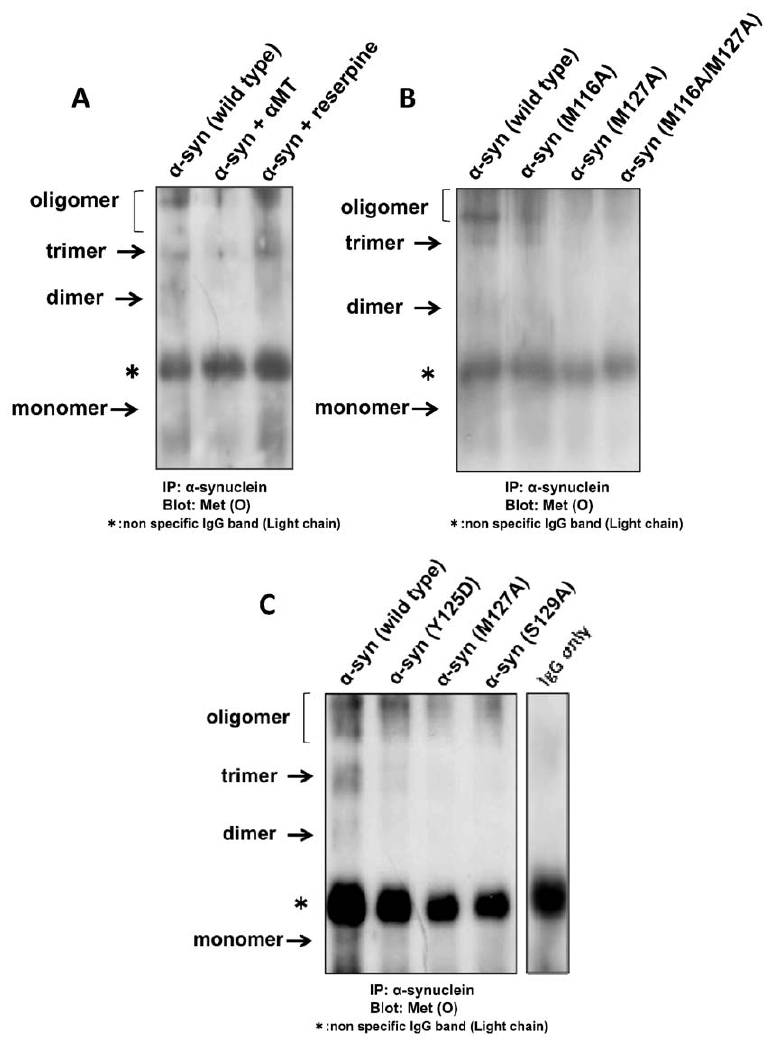
Figure 5. Detection of Met(O) in a -syn. (A) Western blots of a -syn immunoprecipitated (IP) from wildtype a -syn-expressing PC12 cells and immunostained with antibodies against Met(O). Met(O)-labeling was detected in the a -syn from PC12 cells with normal CA metabolism (left lane), but not in the a -syn from those treated with the tyrosine hydroxylase inhibitor aMT (100 m M) (middle lane). By contrast, Met(O) levels were enhanced by treatment with reserpine, an inhibitor of monoamine transport from cytosol to synaptic vesicles (right lane). (B) Met(O)- labeling in lines of PC12 cells expressing methionine mutants of a -syn. Lower levels of Met(O) were detected in the a -syn proteins with methionine mutations (M116A, M127A, M116A/M127A), especially in the M127A or M116A/M127A mutants of a -syn, even though catecholamine metabolism was not suppressed. (C) Met(O)-labeling in lines of PC12 cells expressing various mutants of a -syn. Lower levels of Met(O) were detected in the a -syn proteins with tyrosine (Y125D) and serine (S129A) mutations, compared with wildtype a -syn even though catecholamine metabolism was not suppressed. The lane for IgG control is also exhibited in order to prove the oligomer band is specific for a -syn.